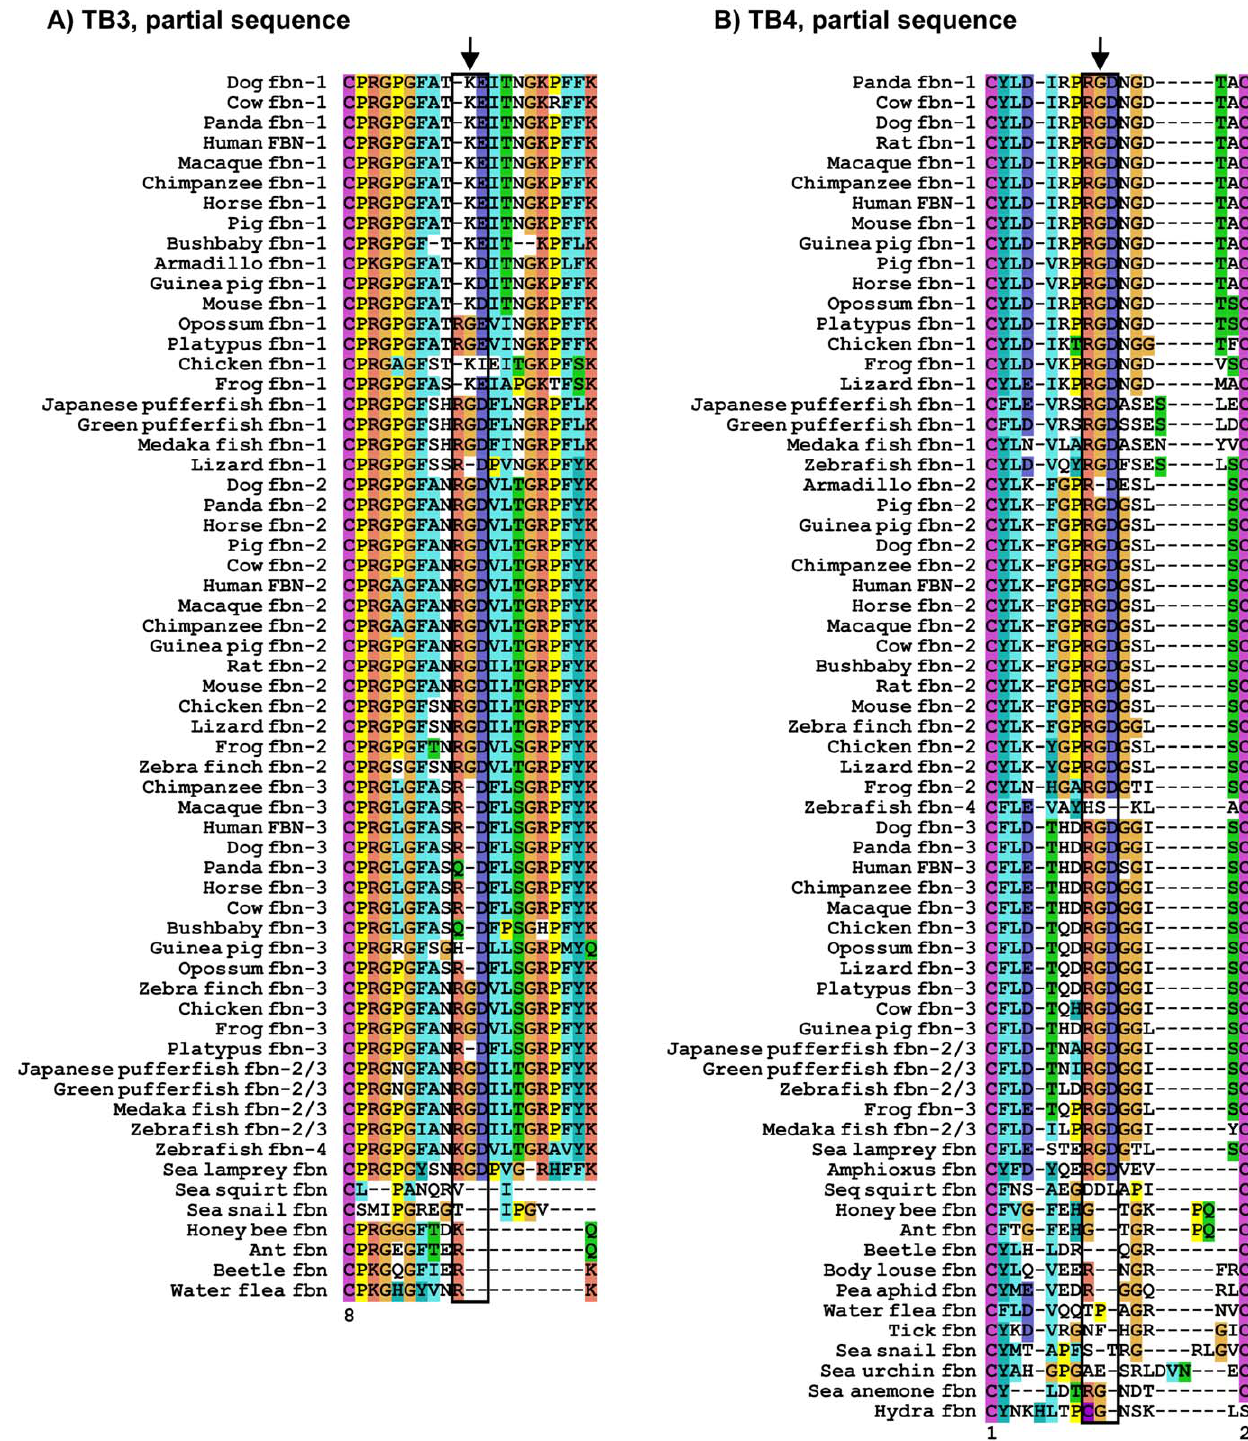
Figure 3. ClustalX alignment of RGD cell interaction sites in A) TB3 and B) TB4. Only the relevant loop containing the RGD sequence is shown. RGD sequences are highlighted by a box and an arrow. The relative numbers of the cysteine residues within the respective TB domain is indicated on the bottom. Note for TB3 the presence of a RGD integrin-binding site in sea lamprey, ray-finned fish fibrillin-1 and fibrillin-2/3, all fibrillin- 2 species and several tetrapod fibrillin-3 sequences. For TB4, the RGD integrin-binding site is present in all vertebrate fibrillins, with the exception of armadillo fibrillin-2. Invertebrate fibrillin sequences do not contain an integrin-binding site in TB4.